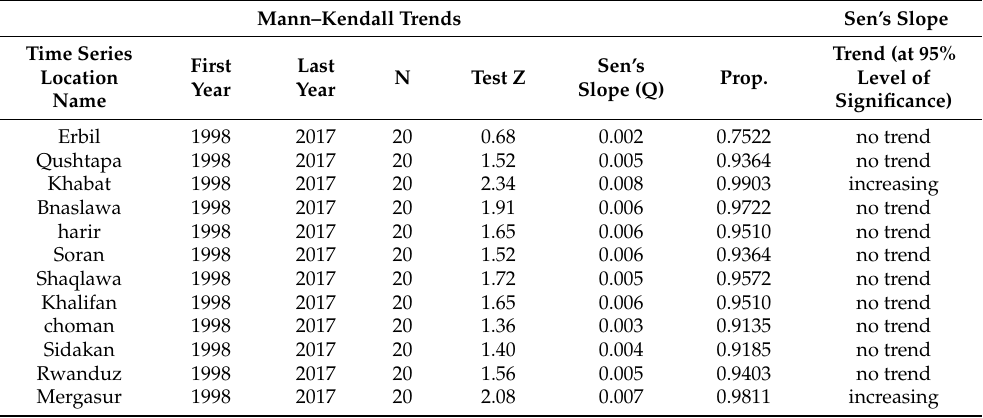
Table 6. NDVI Trends in the KRI over the 20 Years using the Mann–Kendall Test and Sen’s Slope